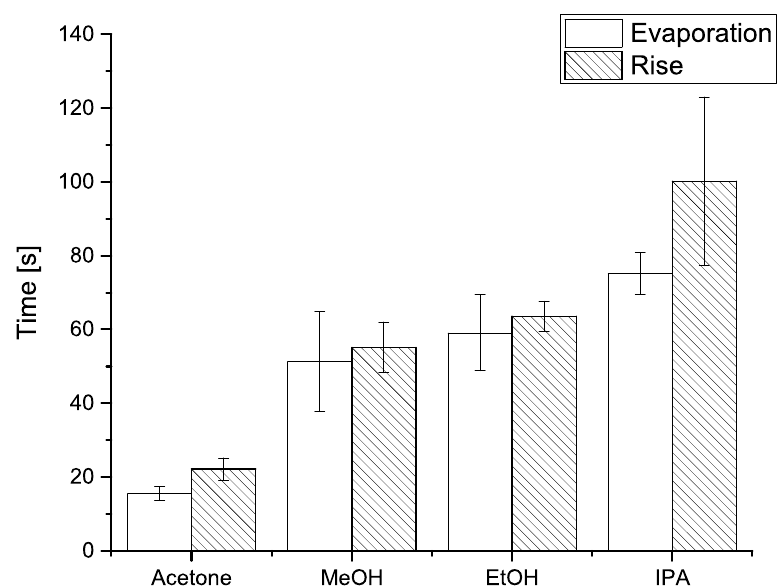
Figure 5. Histogram of mean evaporation time (blank) and resistance rise time (hatched) for (from left to right) acetone, methanol (MeOH), ethanol (EtOH), and isopropanol (IPA). On top of each column a range of one standard deviation is shown. Details are given in Section